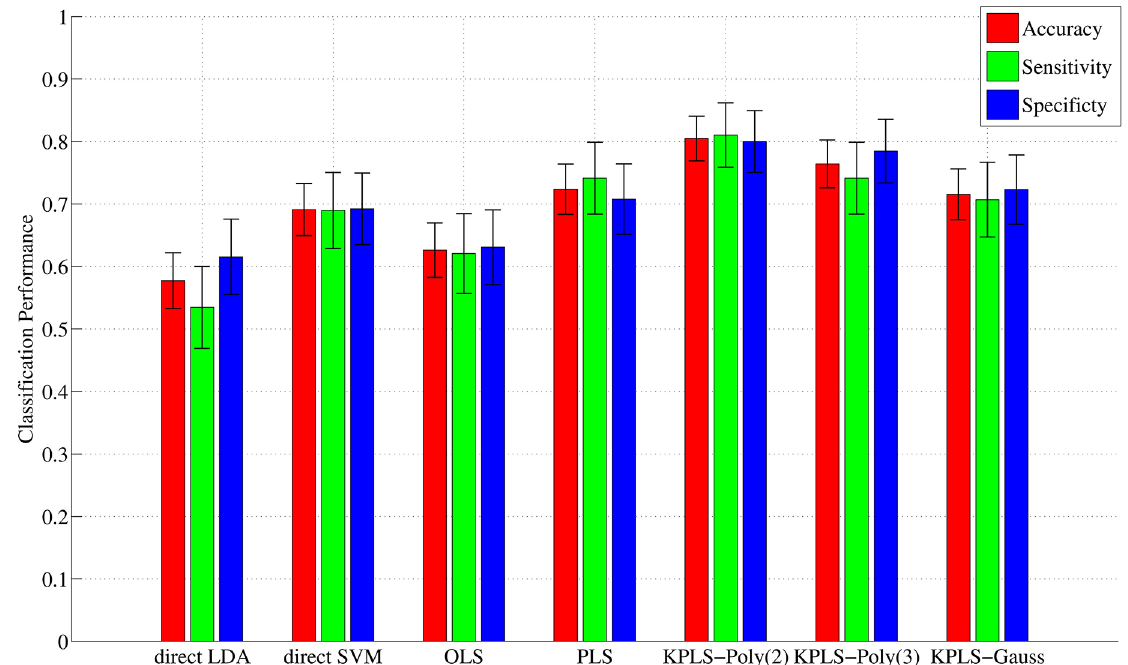
Fig 5. Classification accuracy,sensitivity, and specificity. KPLS-Poly(2) followedby LDA achievesthe best performance (accuracy = 80.5%, sensitivity = 81.0%, and specificity =